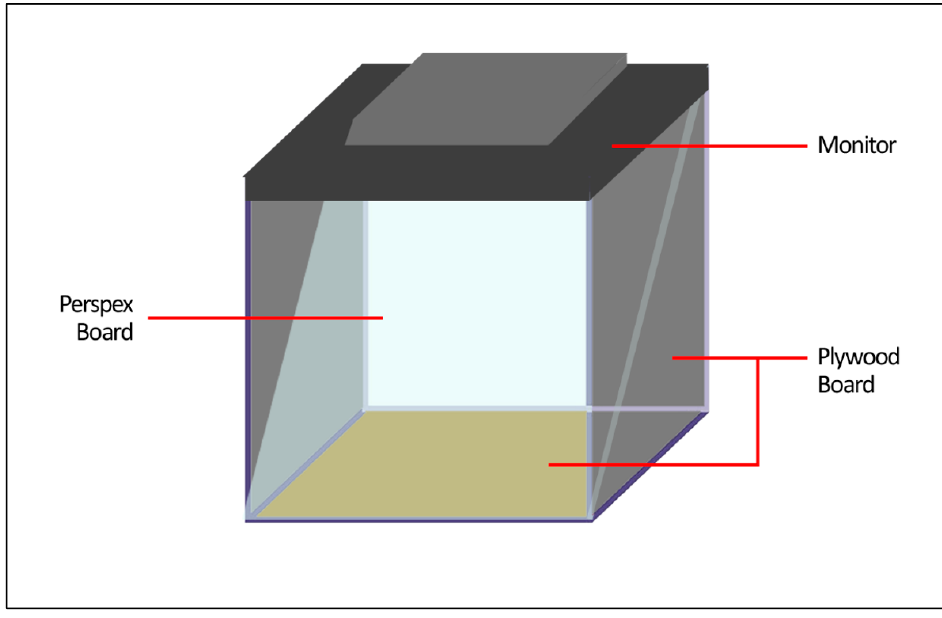
Figure 6. The Z-Hologram setup structure.